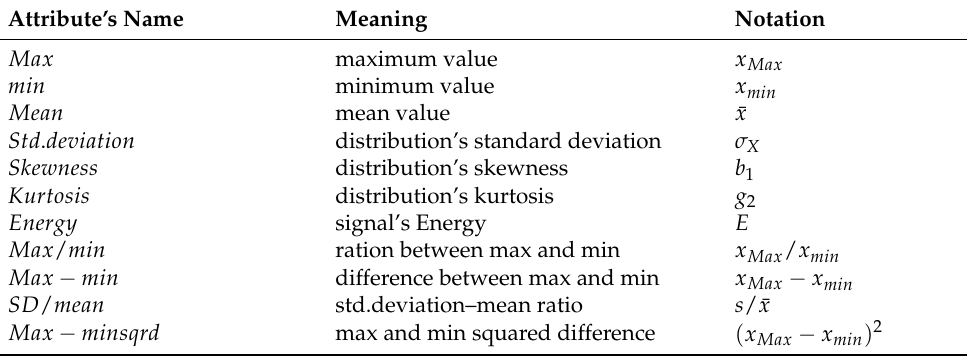
Table 2. Attributes calculated from each